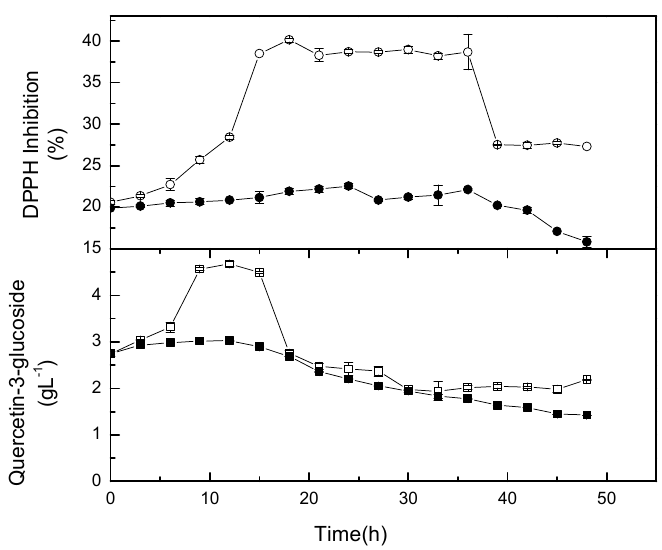
Figure 7. Quercetin-3-glucoside and antioxidant activity in shake flask cultures. The open symbol is growth kinetic at 0 rpm and the closed symbol is growth kinetic at 50 rpm. 229